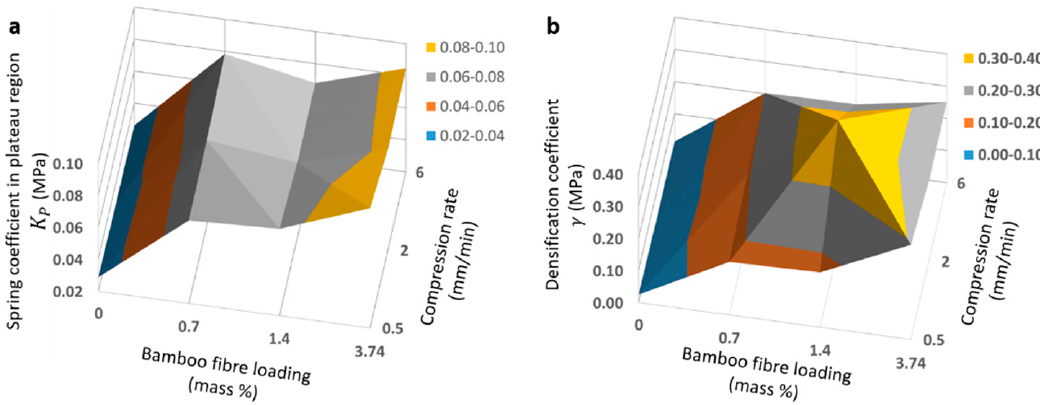
Figure 9. Surface plots visualizes effect of compression rate and bamboo fiber loading on ( a ) spring coefficient in plateau region K P and ( b ) densification coefficient γ